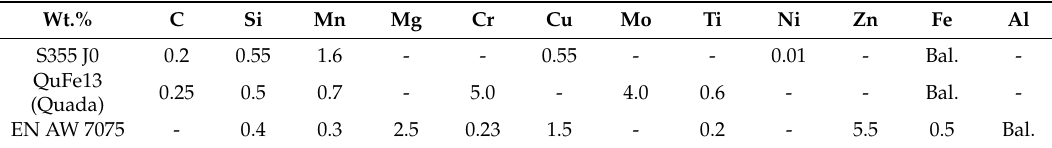
Table 1. Overview of the employed pulsed laser parameter sets.